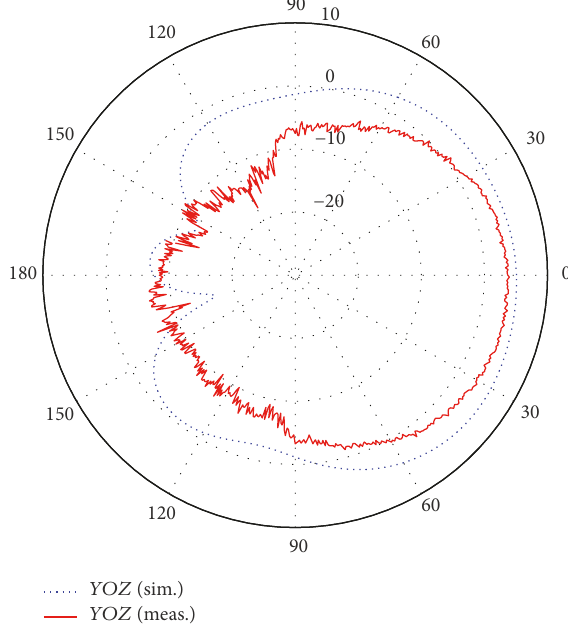
Figure 15: Radiation pattern of the antenna in YOZ plane at 5.725 GHz.